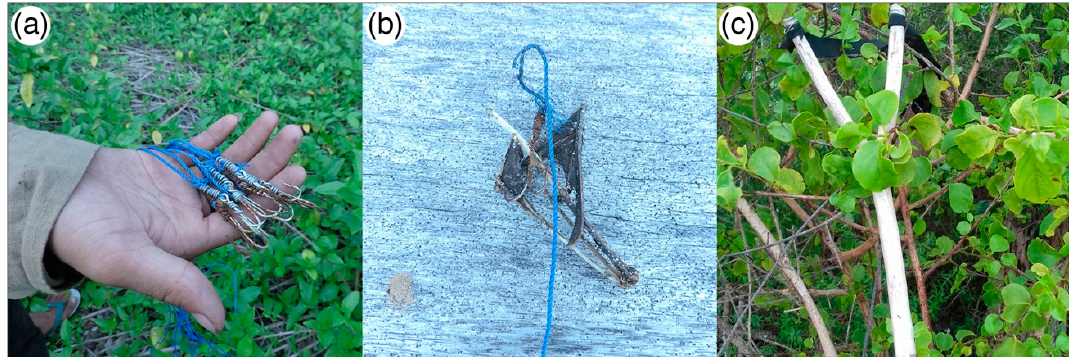
Figure 3. Hunting equipment for flying fox: ( a ) fishing hooks; ( b ) remains of a flying fox wing ripped by a fishing hook; ( c ) slingshot used to shoot the bats.